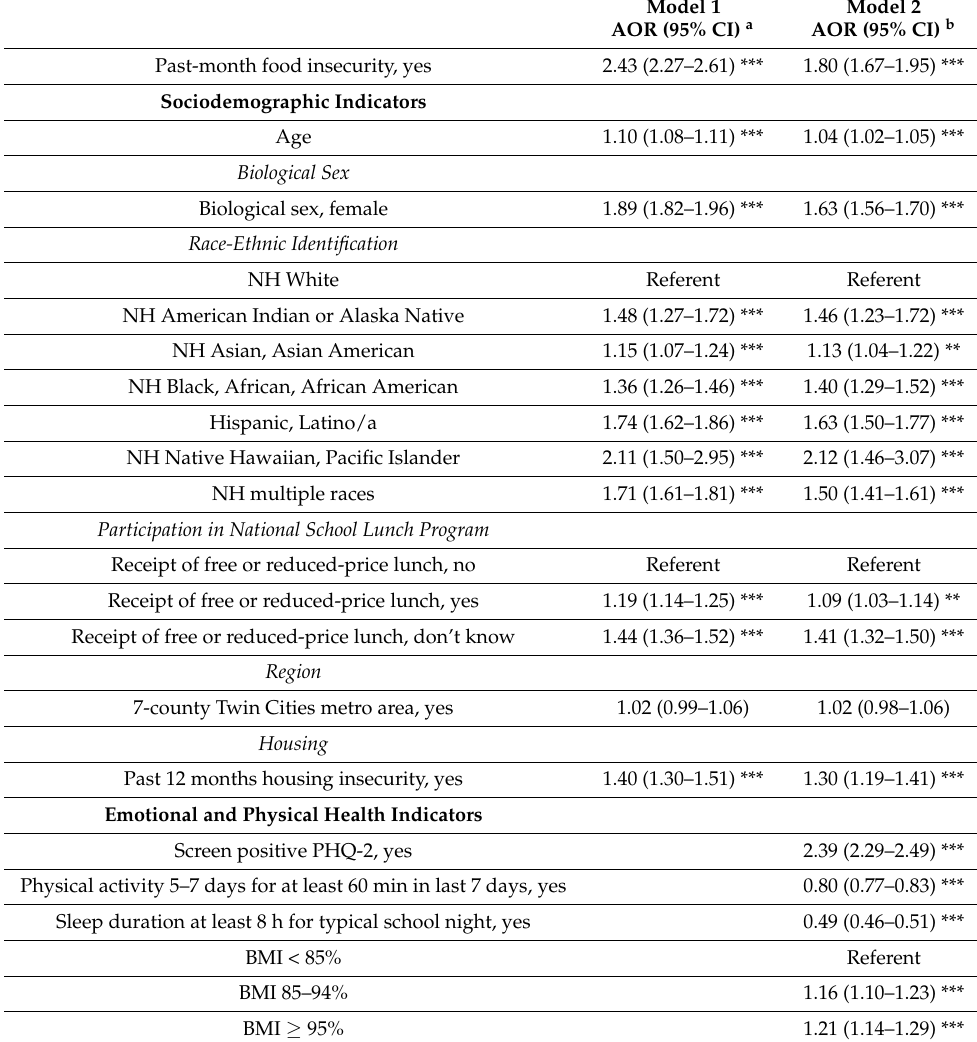
Table 6. Past-Month Food Insecurity and Student Odds of Not Eating